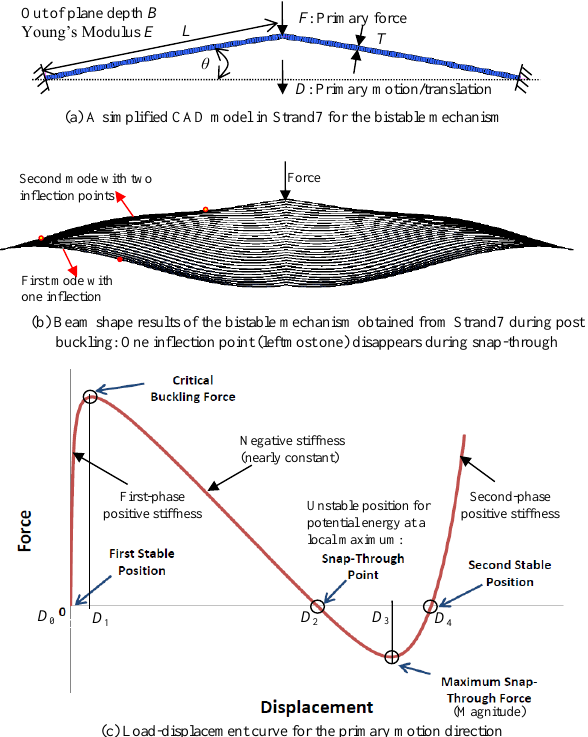
Figure 1. Embodiment of the bistable